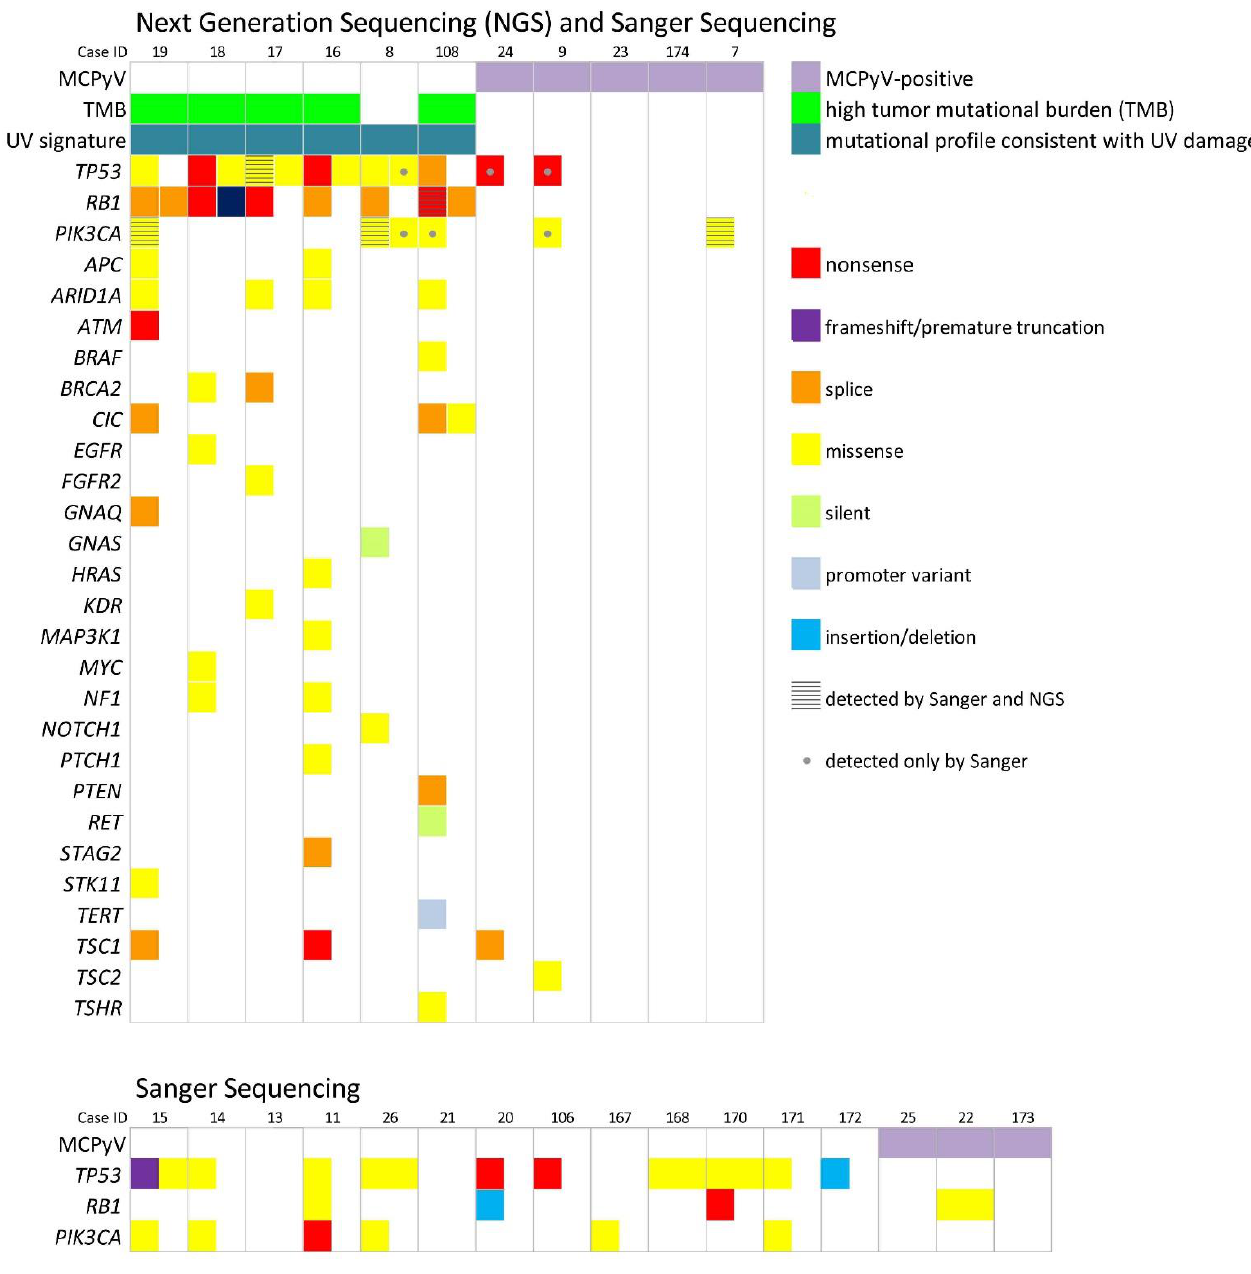
Figure 5. A summary of the next generation sequencing and Sanger sequencing results. Mutations including TP53, RB1, and PIK3CA are more frequently noted in MCPyV-negative versus MCPyV-positive unknown primaries. By next generation sequencing analyses, TP53 and RB1 mutations and/or insertions/deletions with C > T/G > A and CC > TT/GG > AA transitions and high tumor mutational burdens were detected in all six and five virus-negative MCC-UPs, respectively. These findings are supportive of a UV-induced etiology.